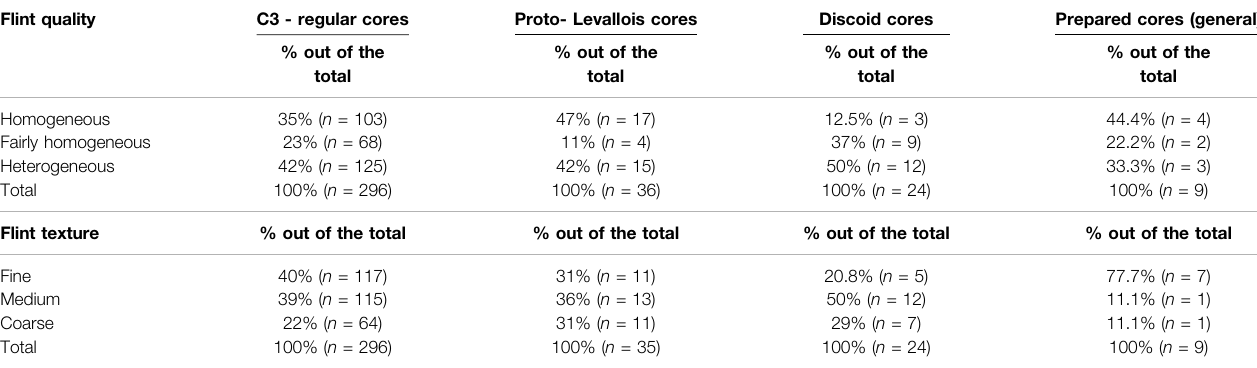
TABLE 4 | Distribution of fl int quality for one and two striking platform cores at Revadim layer C3 as compared to prepared cores from the Revadim assemblages used in our study. Flint